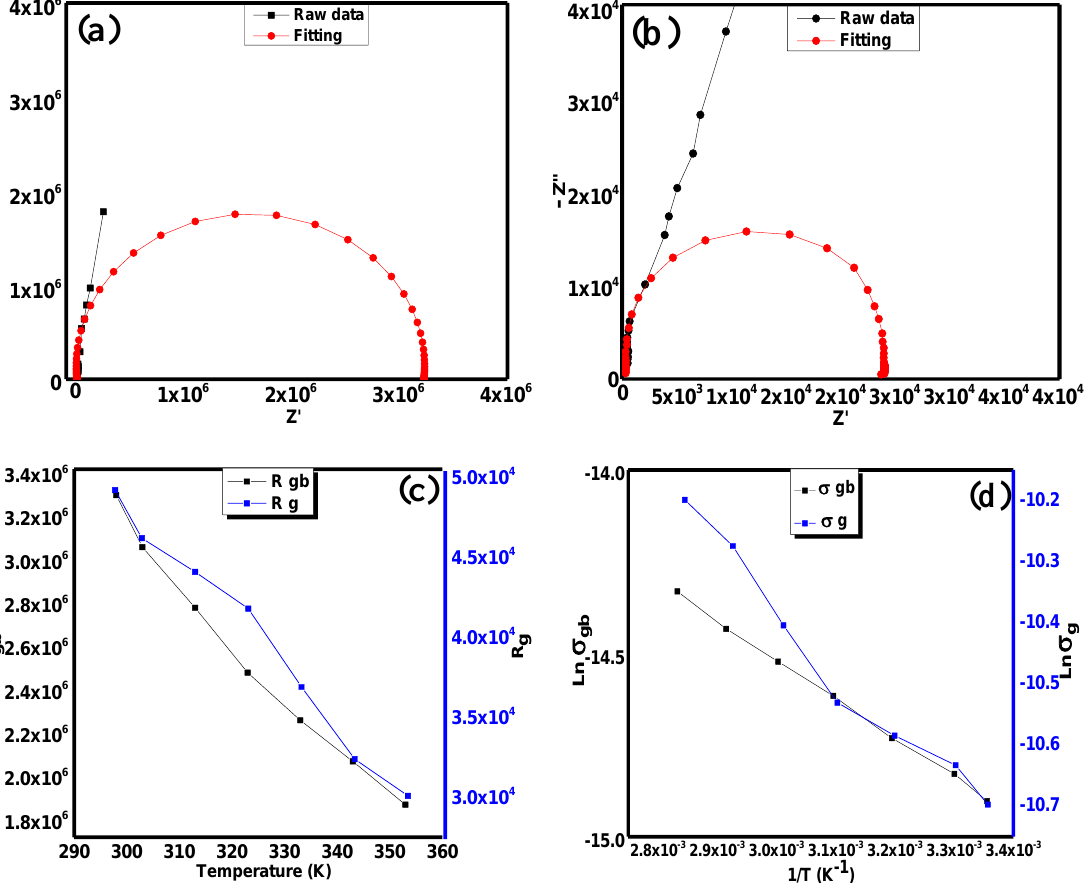
Figure 5. Nyquist plot fitting at ( a ) full frequencies range and ( b ) at high frequencies, ( c ) grain boundaries and grain resistance vs. temperature, and ( d ) ln DC conductivity vs. inverse temperature for grain boundaries and grain structure of Sr 2 CaTeO 6 .